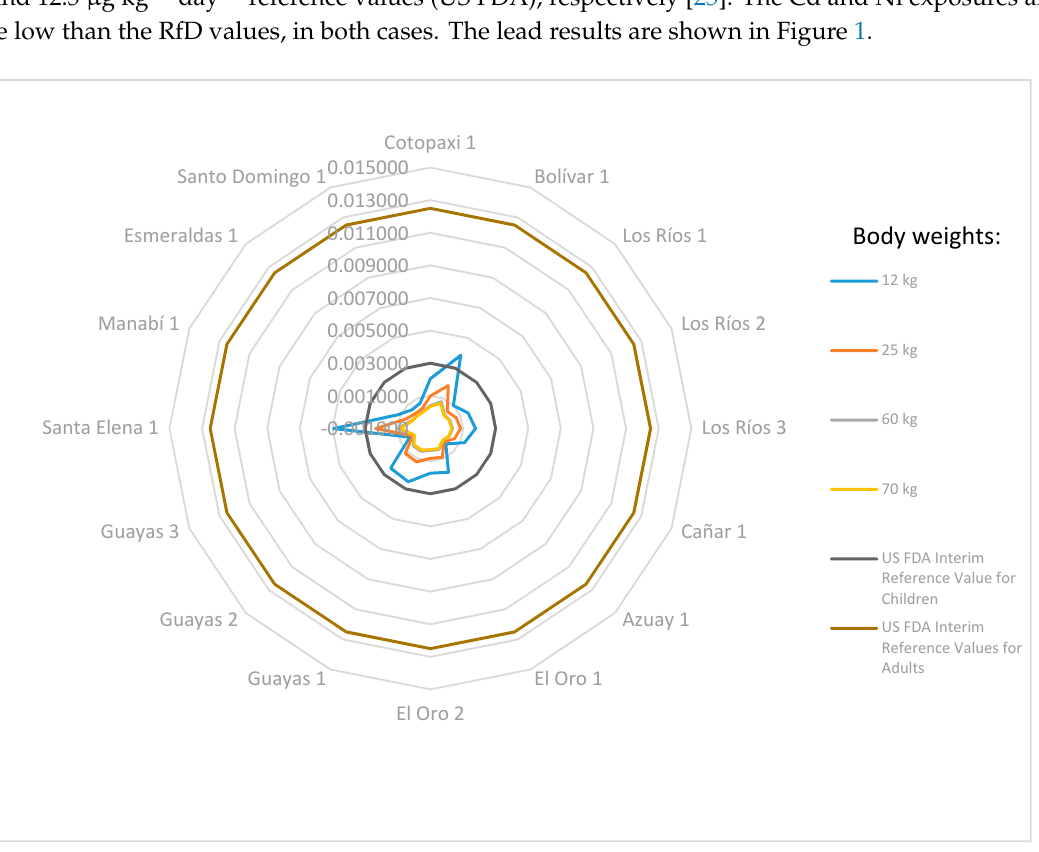
Figure 1. Lead exposure values calculated with sample metal concentrations ( μ g·kg -1 ·day -1 ) compared with the oral reference dose (RfD) of each metal that could be safely consumed daily ( μ g·kg -1 ·day -1 ) for different body weights (kg).